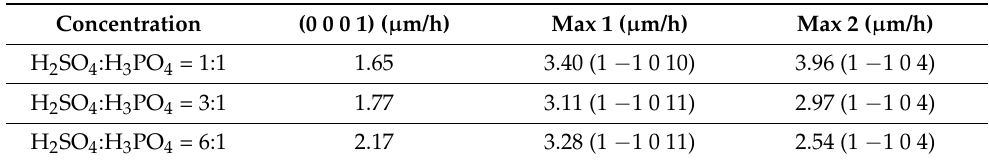
Table 3. Maximum rates (Max 1 and Max 2) at different concentrations (volume ratios of 98 wt% H 2 SO 4 to 87 wt% H 3 PO 4 ).